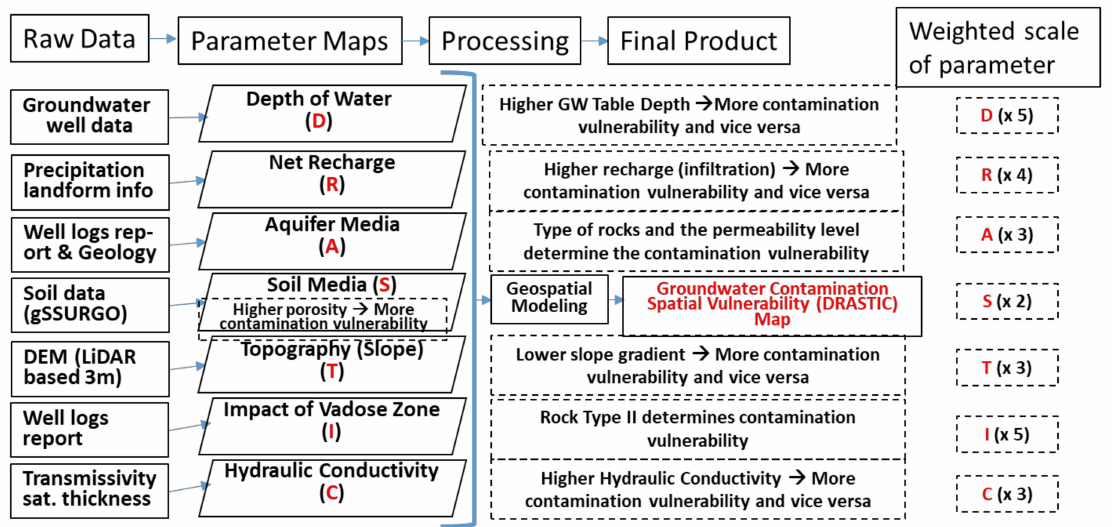
Figure 4. Explanation of each parameter of DRASTIC and its contamination vulnerability scale. Last column explains the DRASTIC model spatial parameter weighted scale. Note: Each parameter is also scaled with a scale of 1–10 (lowest–highest vulnerability) before being combined as the weighted scale. Optimization of weights and ratings of the model parameters are explained in